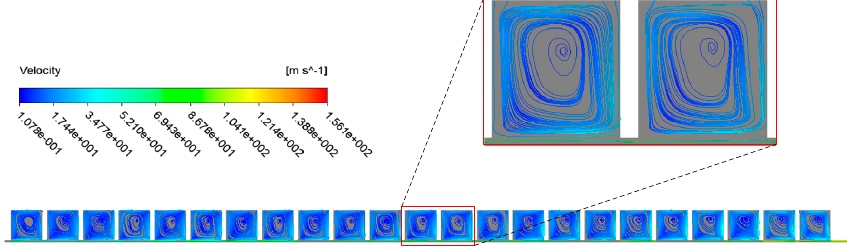
Figure 5. Two-dimensional streamlines on the midplane of the seal.